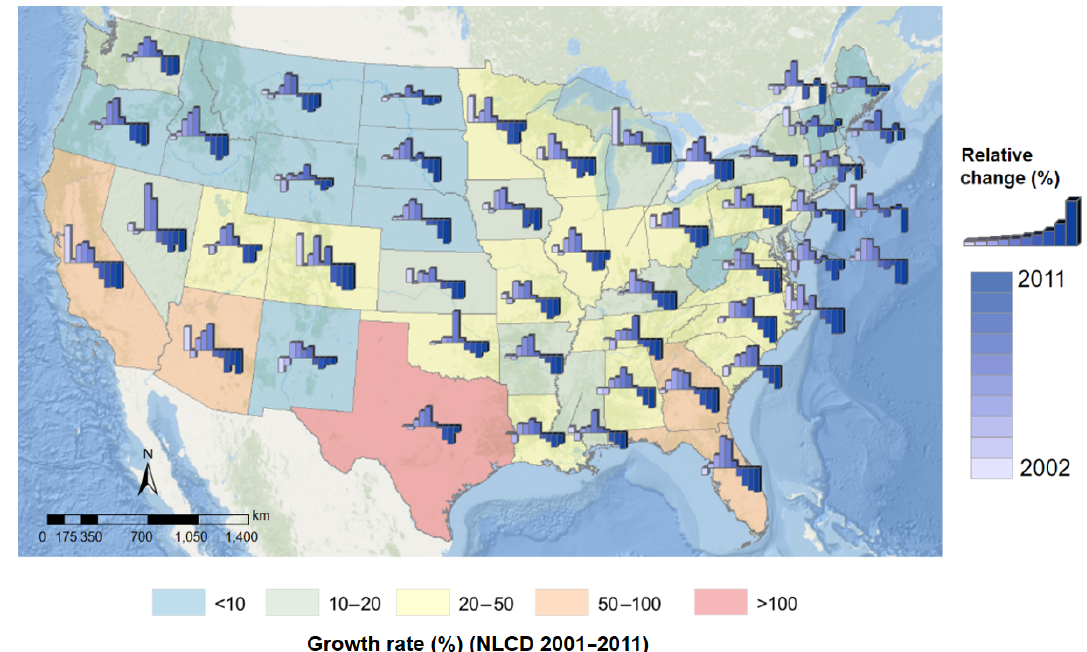
Figure 5. State-based relative change of annual growth of urban areas compared to the mean growth rate of NLCD during the period of 2001–2011 (Basemap data© 2019 Esri).